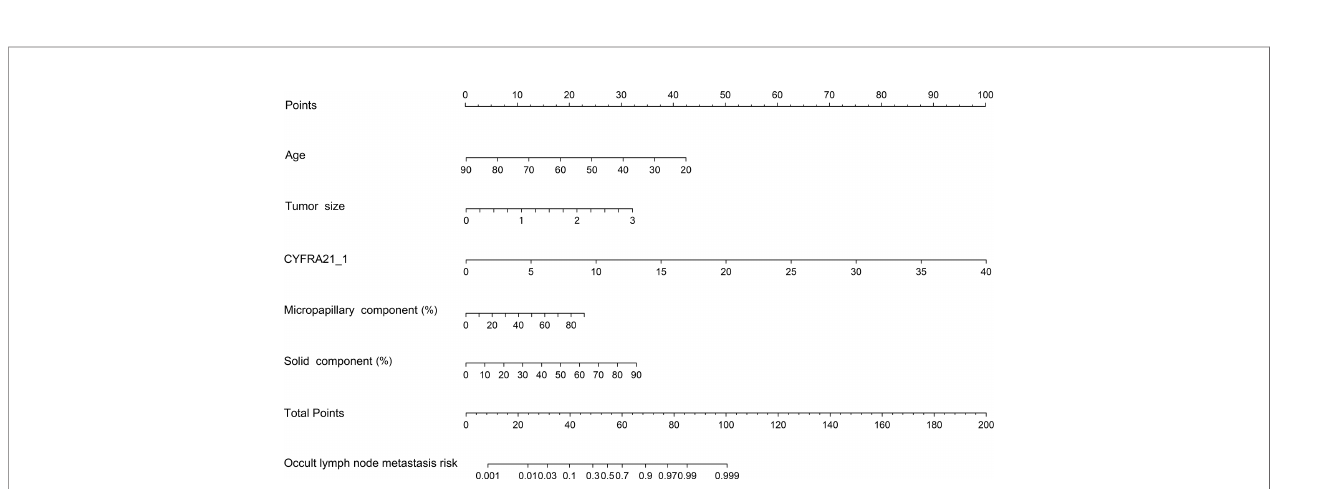
TABLE 3 | Comparison of the correlation between EGFR exon mutation and OLNM. EGFR mutation, % Negative